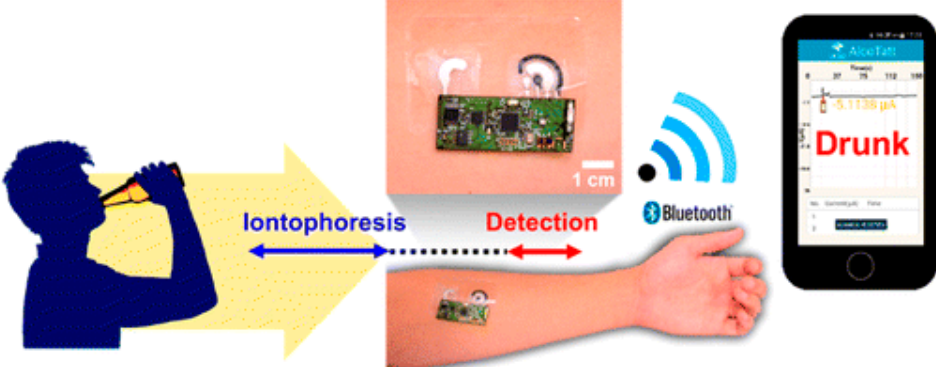
Figure 6. Schematic diagram of a wireless operation of the iontophoretic ‐ sensing tattoo device for transdermal alcohol sensing. In the diagrams of the tattoo ‐ base device, blue and red highlights show the active zones during iontophoresis and amperometric detection, respectively (reprint adapted with permission from Kim et al. 2016; Ref. [168]. Copyright 2016 American Chemical Soci ‐ ety).